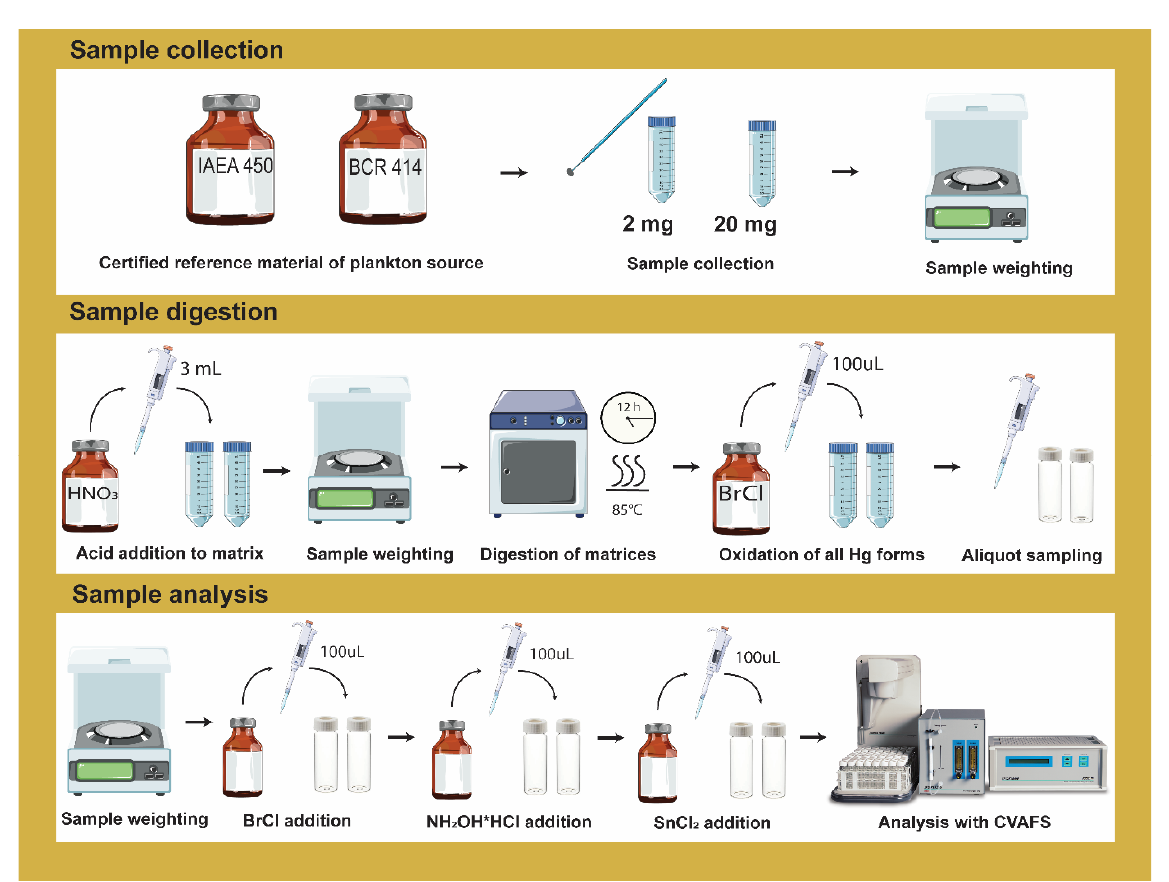
Figure 1. Illustrative scheme of the wet acid digestion procedure used on this study with the three stages well described: sample collection, sample digestion and sample analysis.